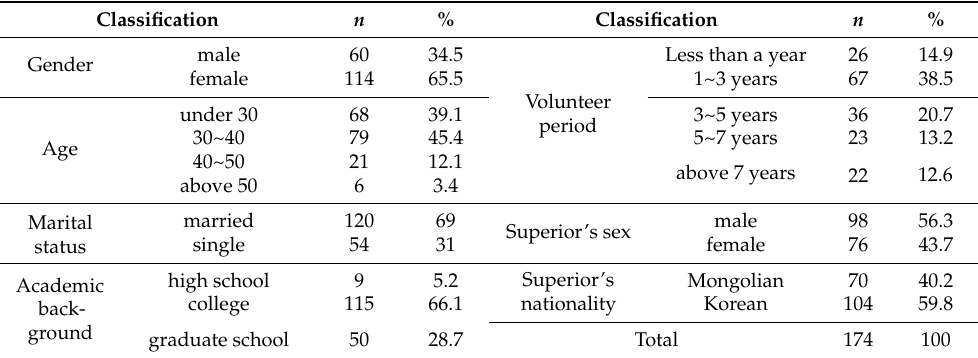
Table 1. Demographic characteristics of samples.